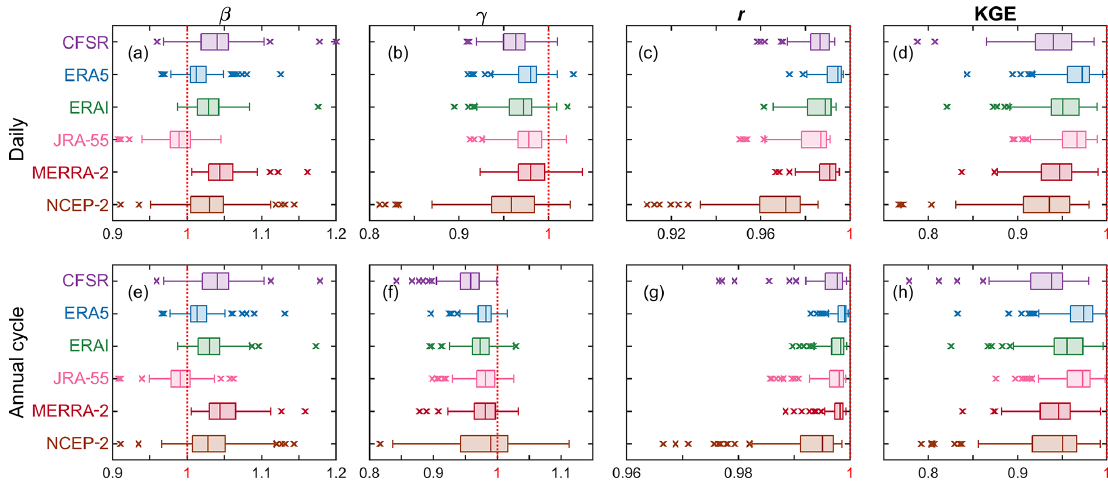
Figure 5. Box–whisker plots of the KGE parameters for the daily time series (a–d) and monthly annual cycle of IWV (e–h) from the reanalyses compared to GPS for the 108